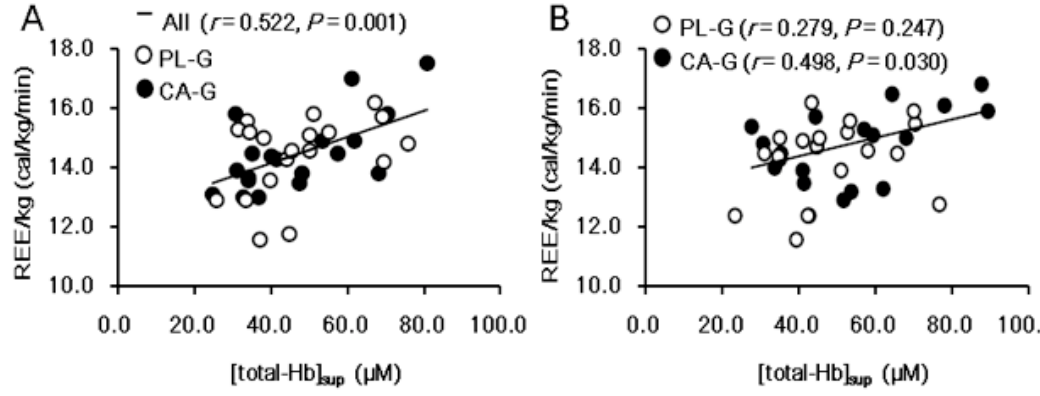
Figure 4. There were significant correlations between [total-Hb] sup and REE/kg in all participants pre-supplementation ( A ) and only in the CA-G in post-supplementation ( B ). Pearson’s correlation coefficient is denoted by r . CA-G, capsinoid group; PL-G, placebo group; REE/kg, resting energy expenditure per kg; [total-Hb] sup , total hemoglobin concentration in the supraclavicular region.